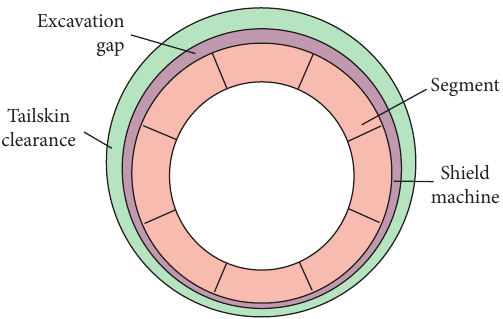
Figure 1: Actual shield